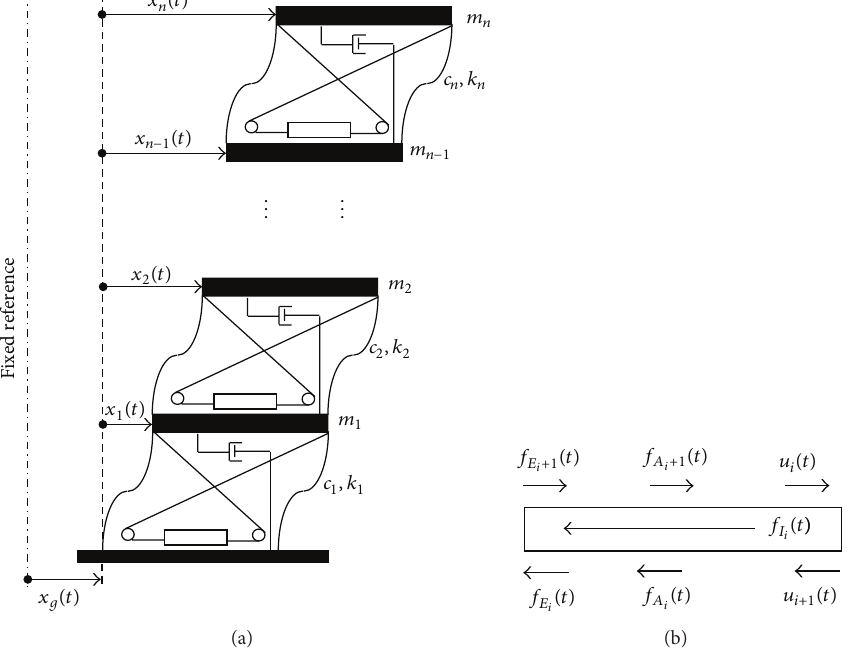
Figure 1: Schematic representation of a multi-degree-of-freedom structure under seismic excitation. (a) Motion of the structure; (b) forces equilibrium of 𝑖 th story unit.